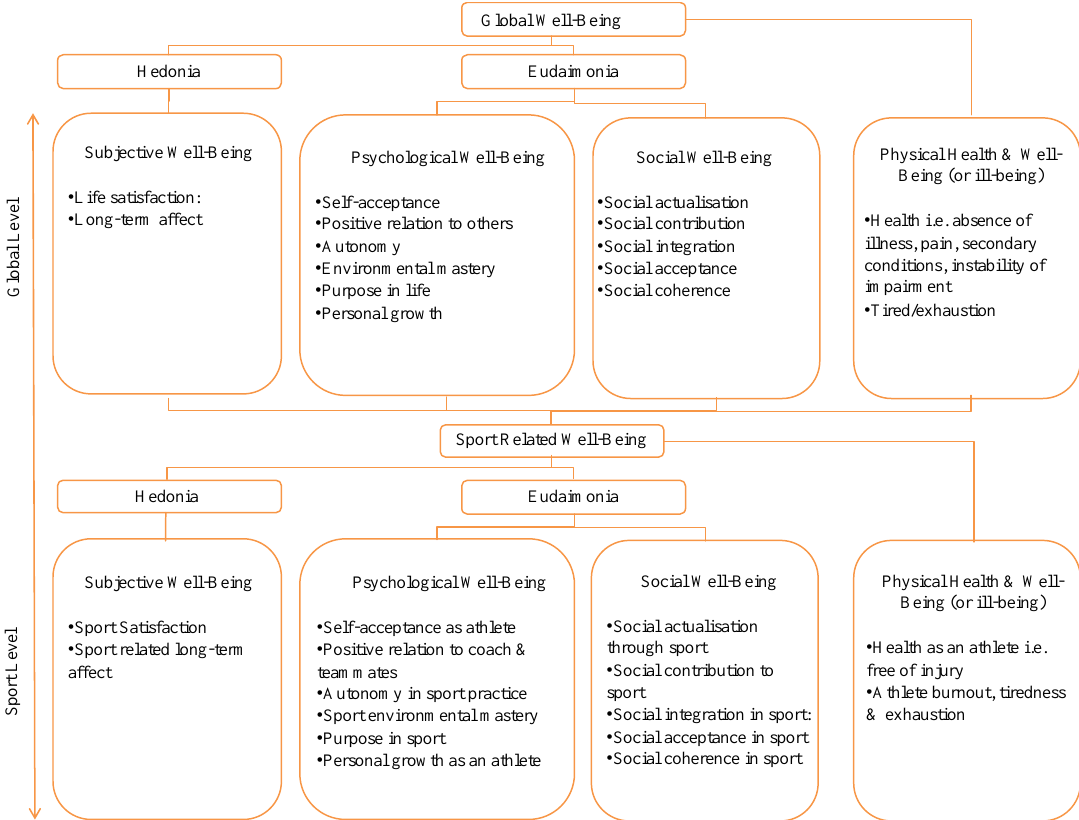
Figure 1: An integrated model of athletes in Para Sports health and well-being in a global and sport- related context (adapted from Macdougall et al., 2016; Lundqvist,